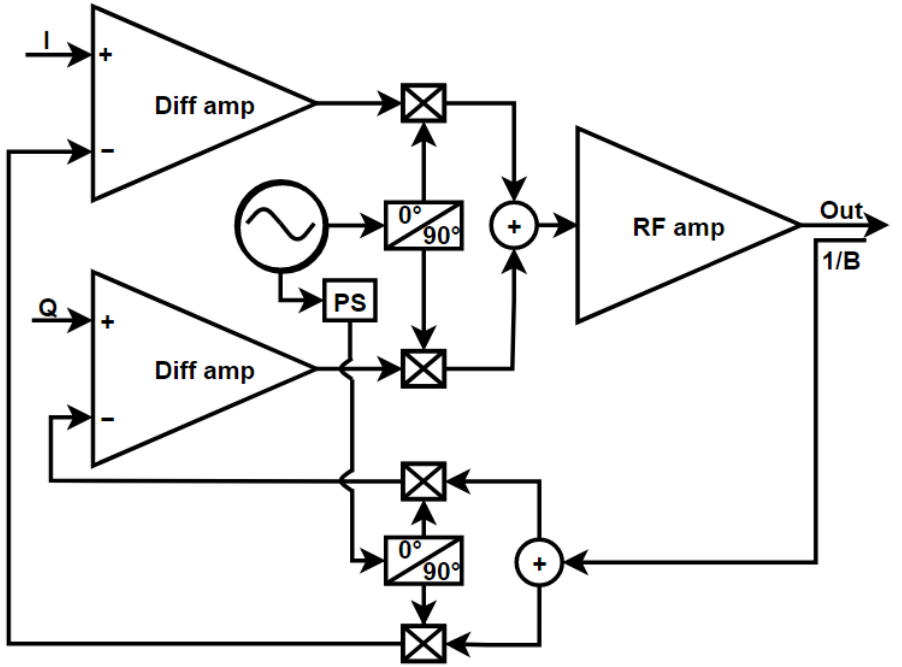
Figure 7. Cartesian feedback transmitter operational diagram.